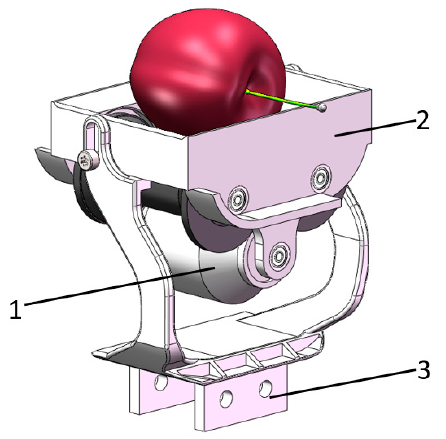
Figure 4. Functional model of the full-view-type grading cup: 1—rotating roller mechanism; 2—multi-functional frame; and 3—base plate.